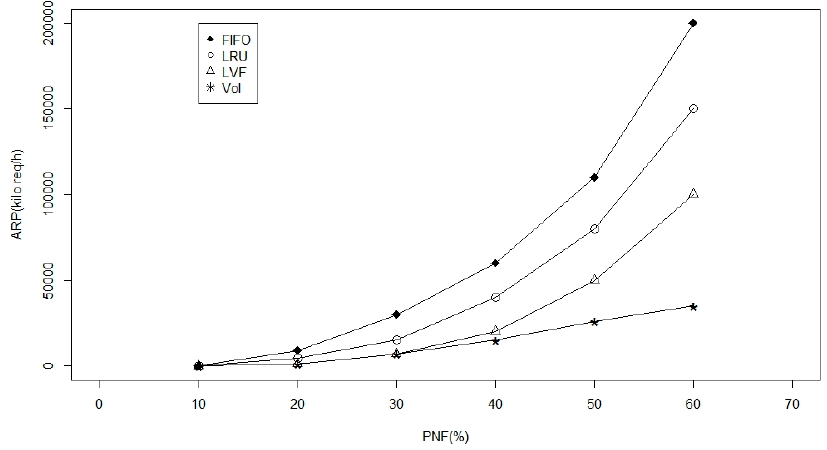
Figure 12. Publisher load versus the probability of node failure in the network.